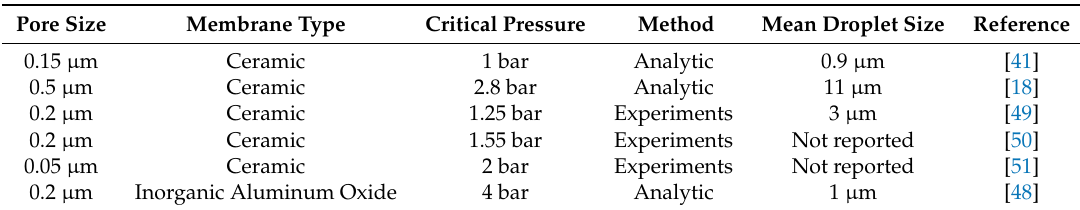
Table 1. Critical pressure for an OiWM found in different